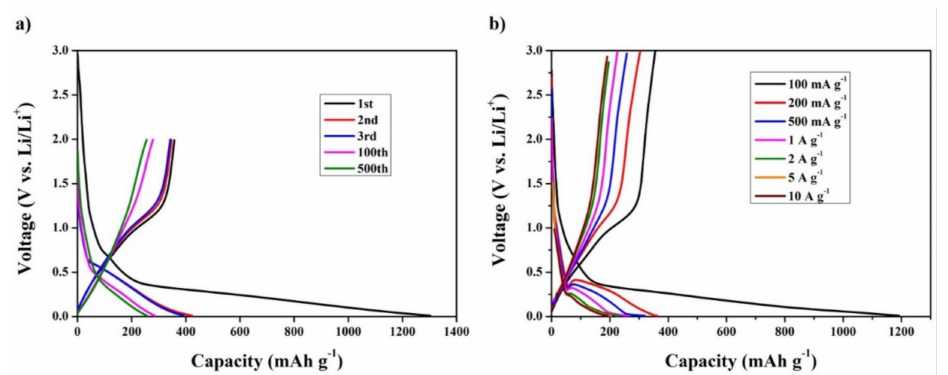
Figure 10. The charge–discharge profiles of the MnO 2 -CNC nanocomposite at ( a ) 100 mA g − 1 and at ( b ) various current